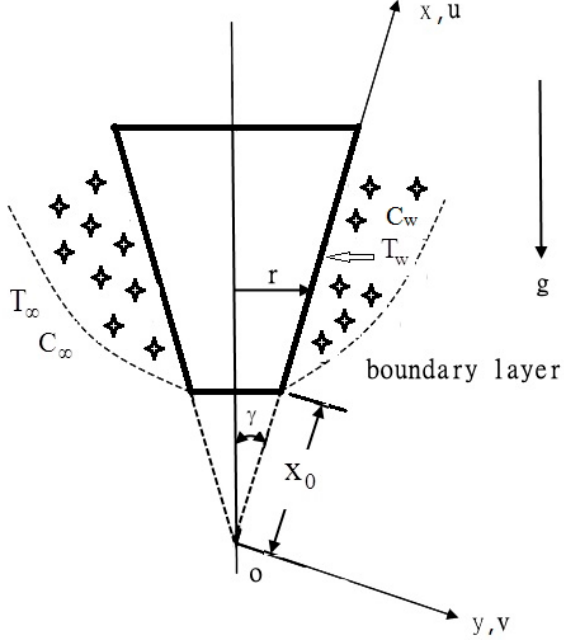
Figure 1. Flow model and physical coordinate system.